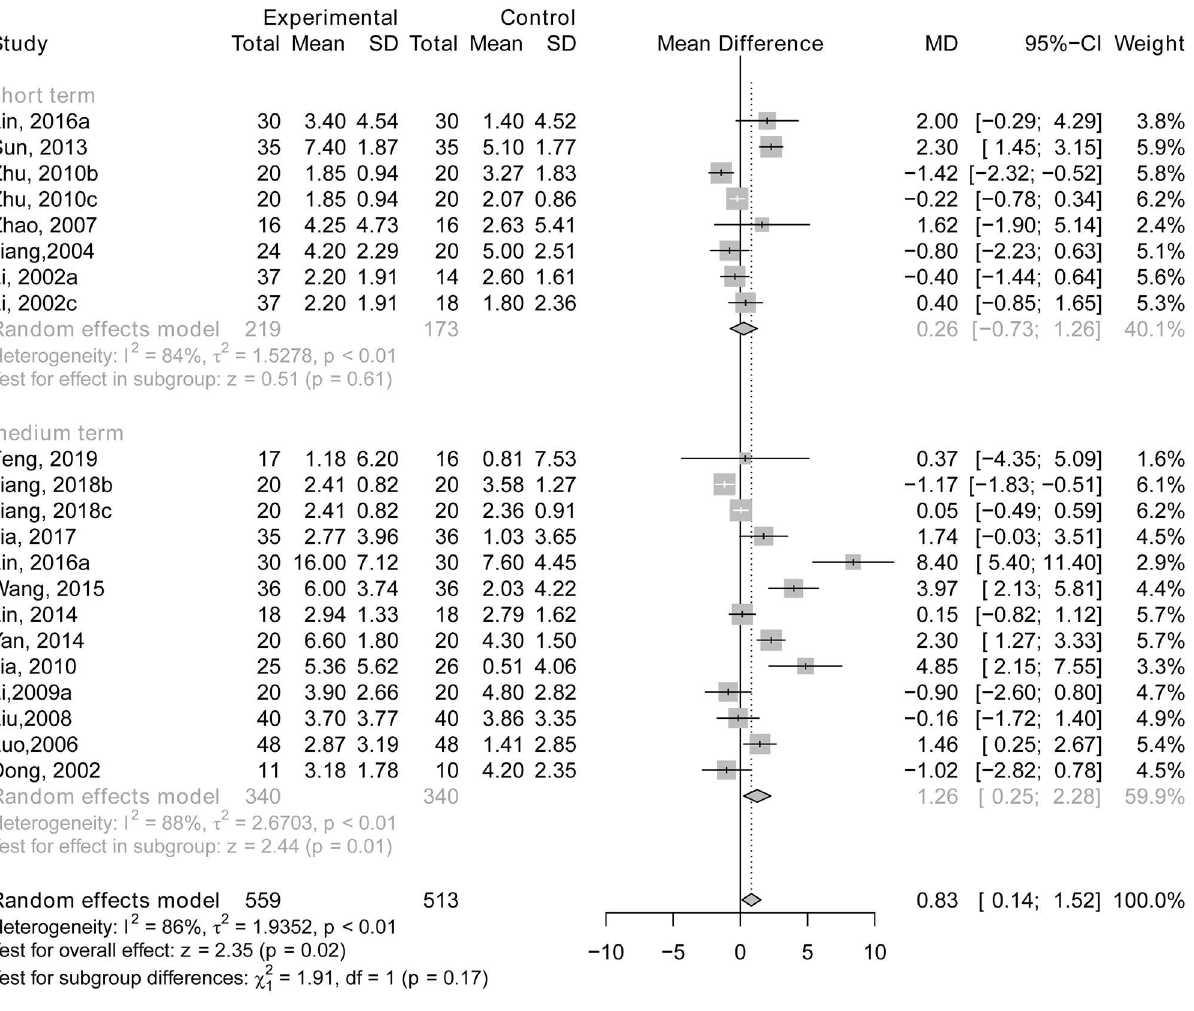
FIGURE 3 | The forest plot of MMSE of acupuncture vs. drug therapy. Lin (2016a), acupuncture vs. Donepezil; Zhu (2010b), acupuncture vs. Donepezil hydrochloride; Zhu (2010c), acupuncture vs. Yizhijiannao; Li (2002a), electroacupuncture vs. Nimodipine; Li (2002c), electroacupuncture vs. Dangguishaoyaosan; Jiang (2018b), acupuncture vs. Donepezil hydrochloride; Jiang (2018c), acupuncture vs. Jiannaosan; Li (2009a), acupuncture vs.